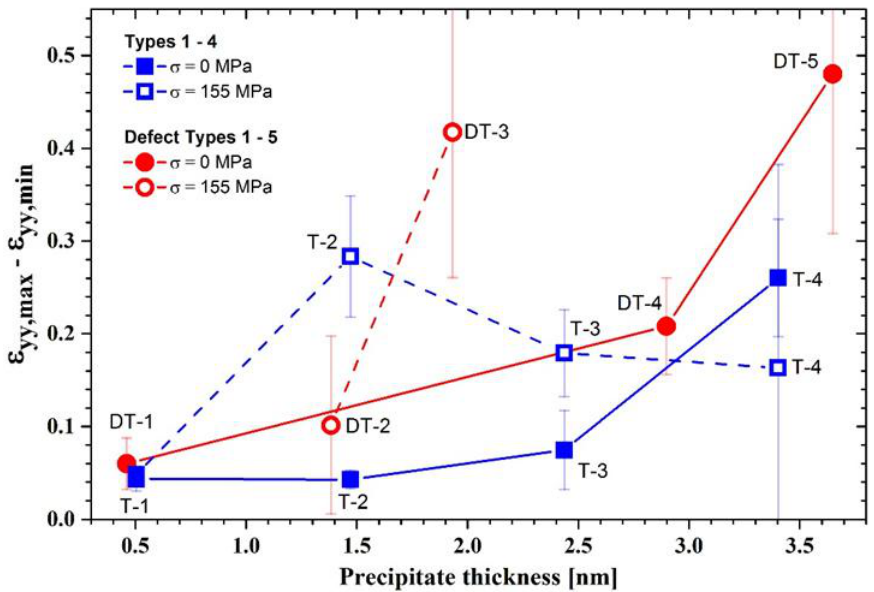
Figure 12. ε yy,max – ε yy,min for different T 1 thickness and stacking after stress free aging and after creep testing calculated from the ε yy line profiles in Figure 11. Blue, Types 1–4; red, Defect Types 1–5. Error bar for T-2 is smaller than symbol height.